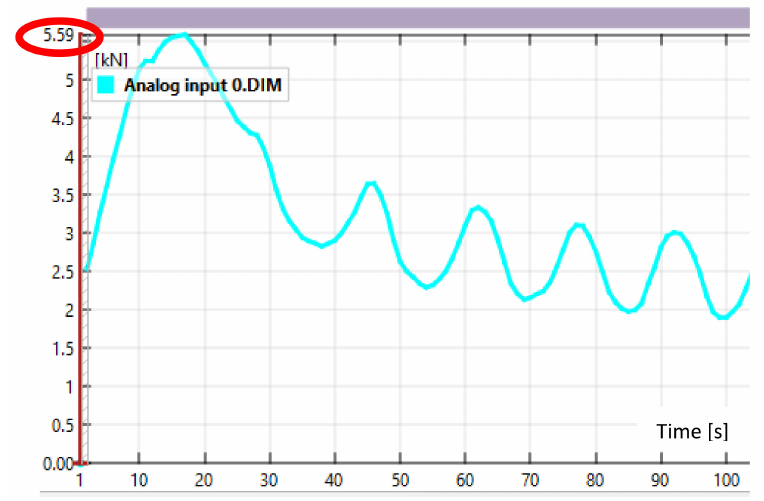
Figure 8. Force values read from source analog input 0 when using the wrong filter numerical